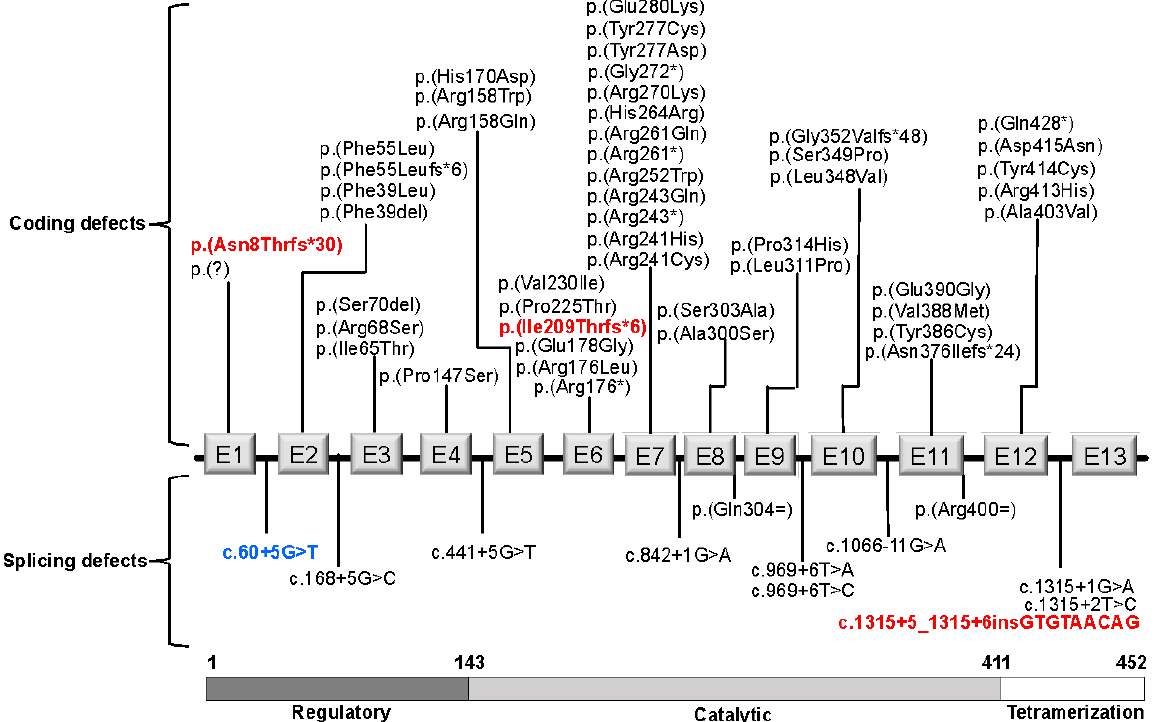
Figure 3. PAH gene diagram showing the localization of the 60 types of variants found in the present study. Novel variants are in red bold type. The most common pathogenic c. 60 + 5G > T splicing variant (14.5% of the PAH alleles) is highlighted in blue bold type. The apparently synonymous variants, p. (Gln304=) and p. (Arg400=), disrupt an exon splicing enhancer element, leading to a splicing defect (BIOPKUdb). E1-E13 diagrammatic representations of exons 1 to 13 of PAH